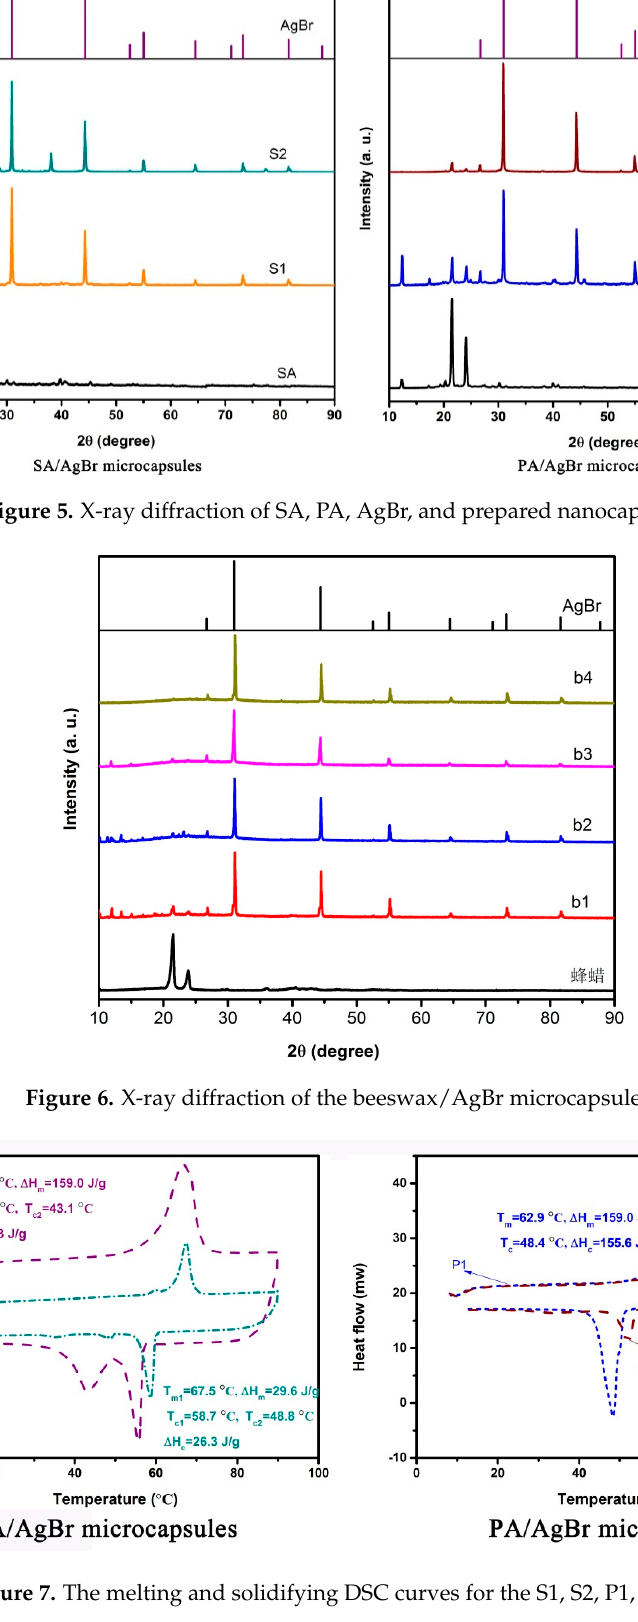
Figure 7. The melting and solidifying DSC curves for the S1, S2, P1, and P2. Table 2. DSC data for the prepared fatty acid/AgBr micro/nanocapsules.